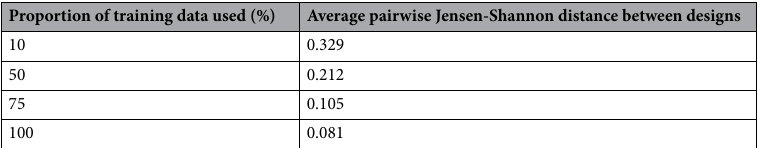
Table 3. Variability in auction design predicted by neural network vs training set size.